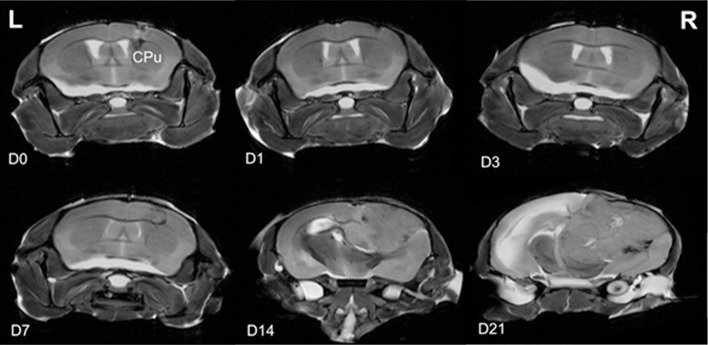
Ex vivo non-contrast T2-weighted 2D MRI scans of ex vivo brains depicting the tumor progression.Panels show MRI scans at day 0 (D0), D1, D3, D7, D14, and D21 post-inoculation of murine glioma Gl261 cells into the caudoputamen (CPu). Left (L) and right (R) of the brain are indicated. Images are representative of N = 3 mice per time point.